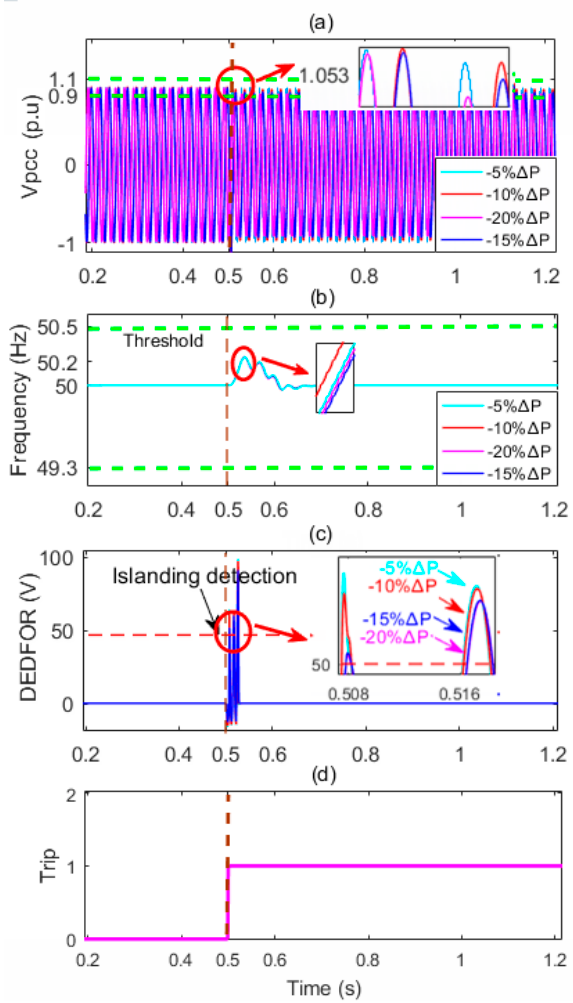
Figure 8. Case2, Scenario II: the results of analysis for decreased active power mismatch, ( a )Voltage at PCC; ( b ) frequency at PCC; ( c ) output of the proposed DEDFOR detector; ( d ) the trip signal for CB1.